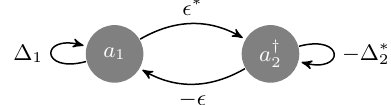
FIG. 9. Graph for two-mode squeezing. The graph provides us with the mode-coupling matrix M . The covariance matrix V out can then be calculated according to Eq. (E8) or Eq.